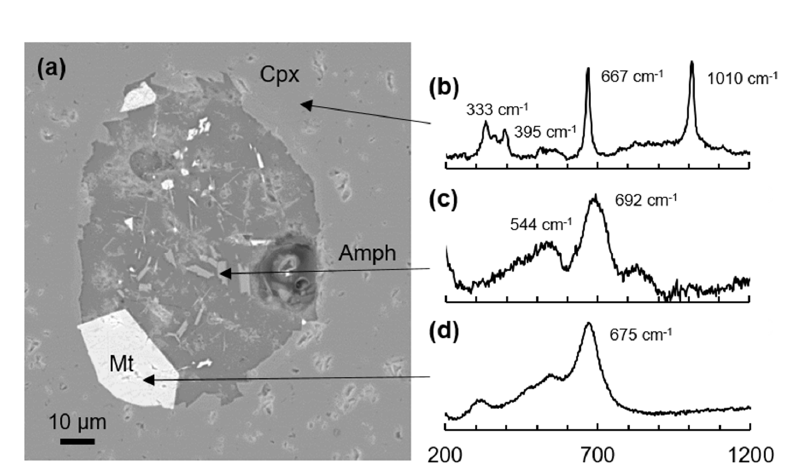
Figure 5. ( a ) BSE image of the representative melt inclusion in Dokdo and Ulleung Islands with ( b – e ) Raman spectrum of representative mineral phase. The melt inclusion is hosted in clinopyroxene ( b ) and consists of amphibole ( c ) and Ti-magnetite ( d ). The y -axis of Raman spectrum represents intensity. Table 2. Range of Raman spectrum of representative mineral phases in this study and representative Raman spectrum from RRUFF database (cm –1